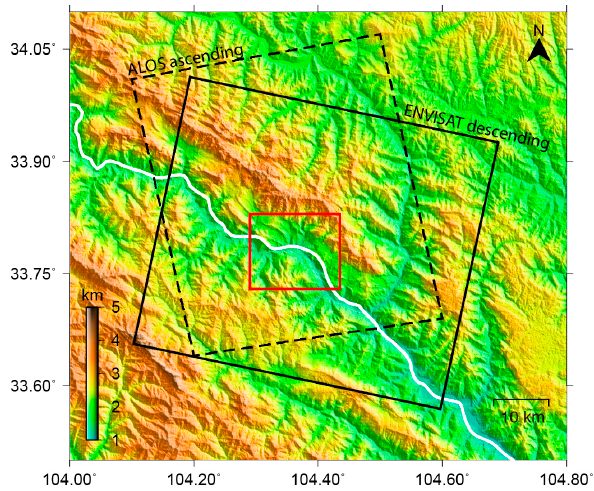
Figure 1. Shaded-relief map of Zhouqu. The red box reveals the scope of the study area. Black real and dashed boxes indicate the coverages of the Advanced Land Observing Satellite (ALOS) ascending and Environmental Satellite (ENVISAT) descending datasets, respectively. The white line represents the Pai-lung River.